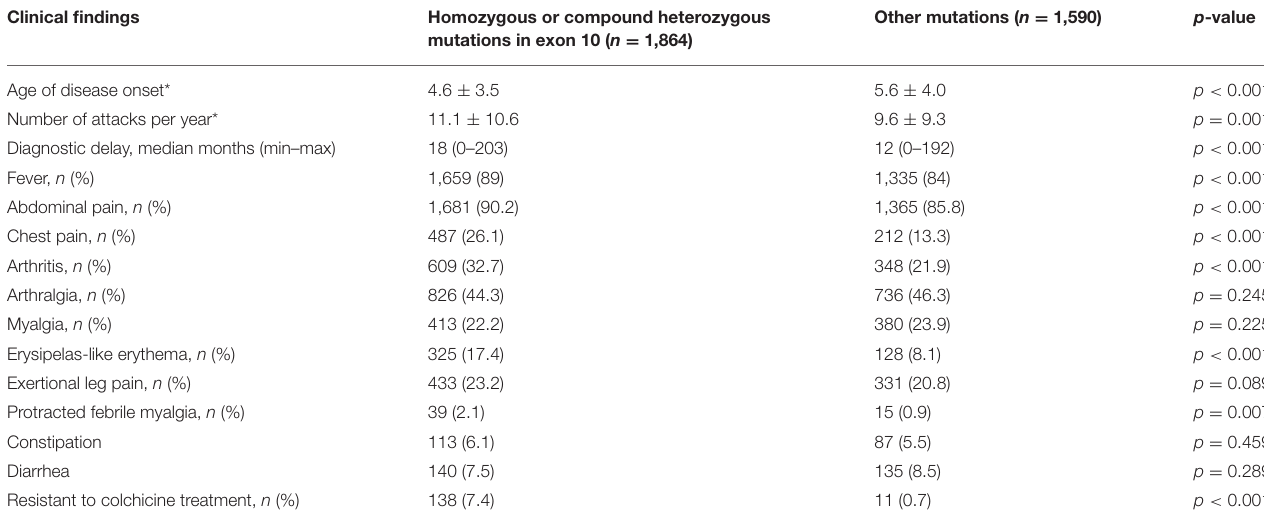
TABLE 4 | The differences between Familial Mediterranean fever patients carrying homozygous or compound heterozygous mutations in exon 10 and patients carrying other mutations. Clinical